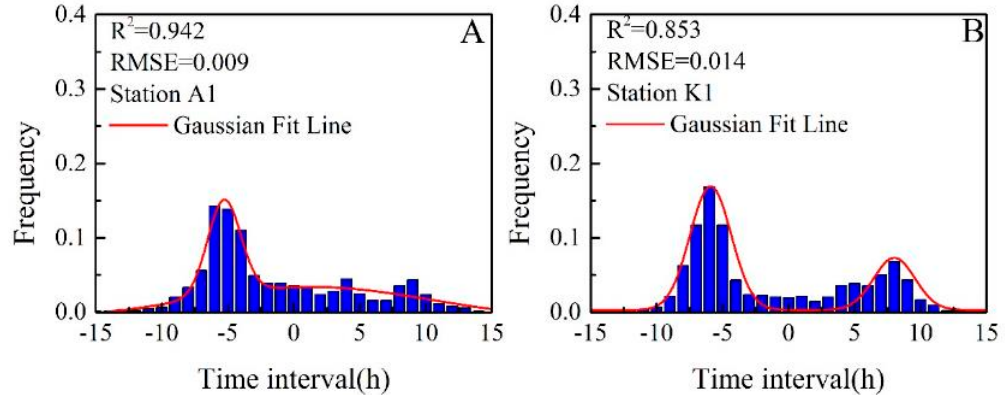
Figure 12. Histogram of the time interval between the maximum SSC and the THW at stations A1 ( A ) and K1 ( B ). Thick red lines show the Gaussian fit.